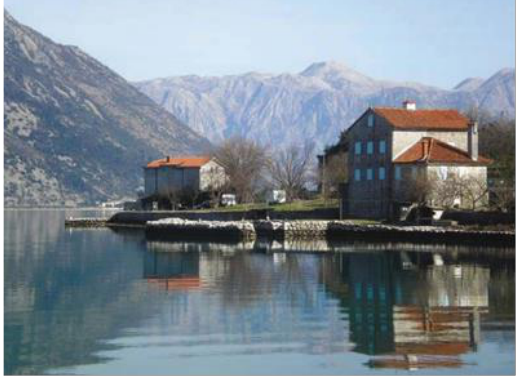
Figure 5. Coastline of Kostanjica: piers, docks and old stone houses (Source: